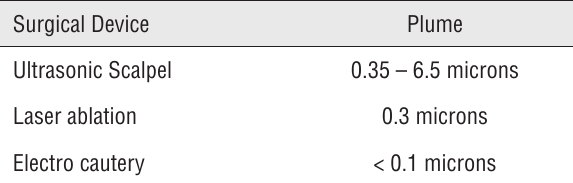
Table 1 - Expected debris from the various categories of energy devices used in the abdomen.